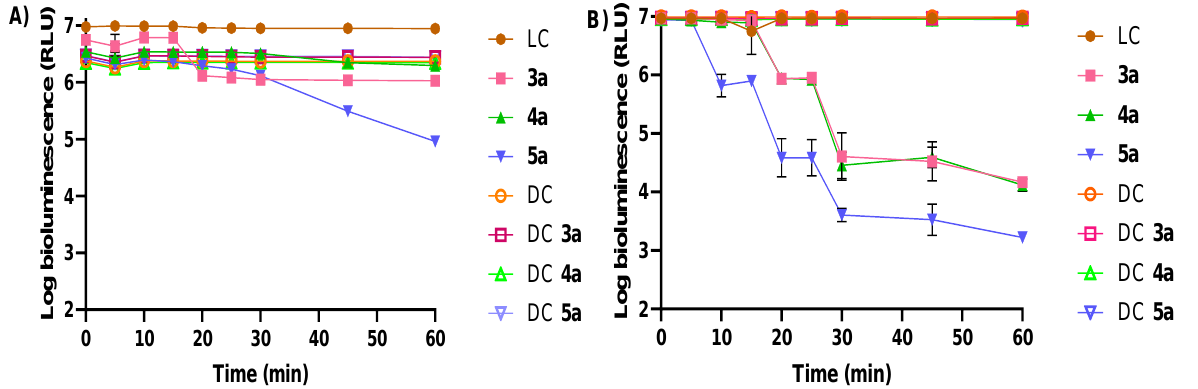
Figure 3. Bioluminescence monitoring of E. coli treated with PSs Por 3a – 5a at 5.0 µM at different irradiation times, under white light irradiation at ( A ) 25.0 mW cm −2 and ( B ) 50.0 mW cm −2 . The values are expressed as the means of three independent experiments; error bars indicate the standard deviation; DC — dark control; LC — light control. Lines combine experimental points. Comparing inverted methoxypyridinium Pors 3a – 5a and thiopyridinium Pors 6a – 8a at a concentration of 5.0 μ M and an irradiance of 25 mW cm −2 (Figure 4), it was observed